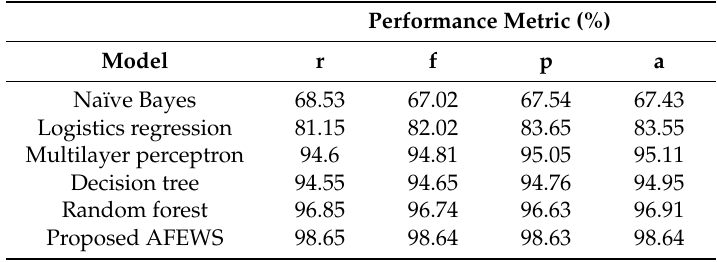
Table 5. Performance comparison of several classification models.